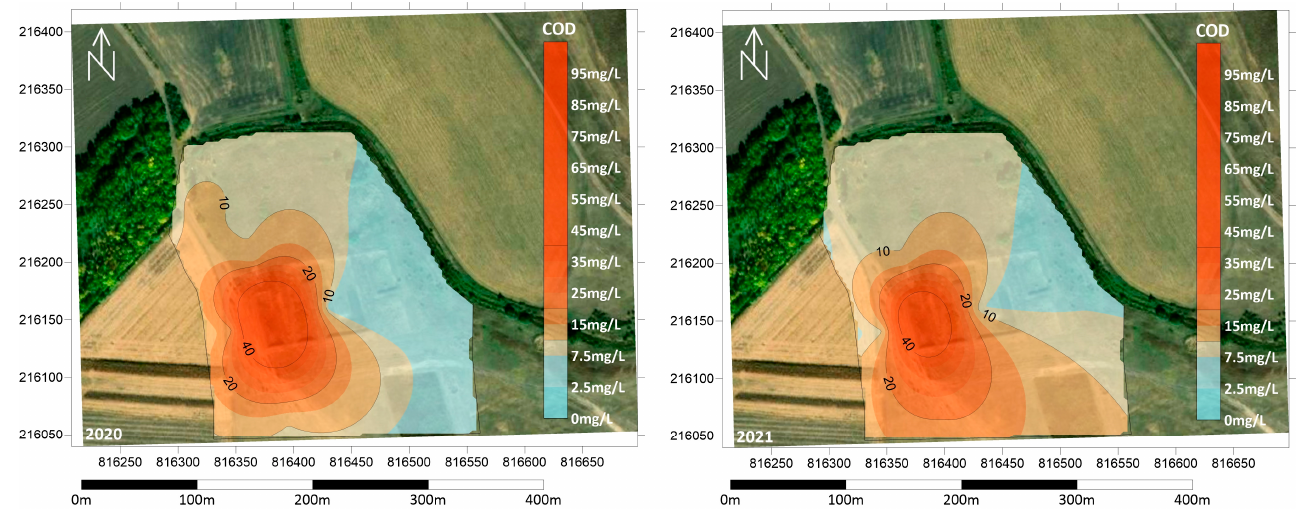
Figure 6. Texture spatial distribution of COD concentration in the summers of 2020 and 2021.